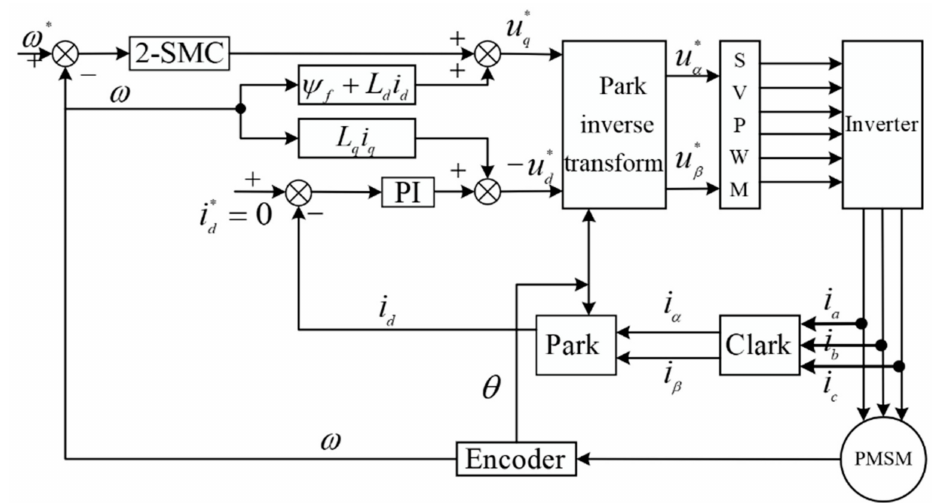
Figure 2. Schematic diagram of second-order sliding mode control of